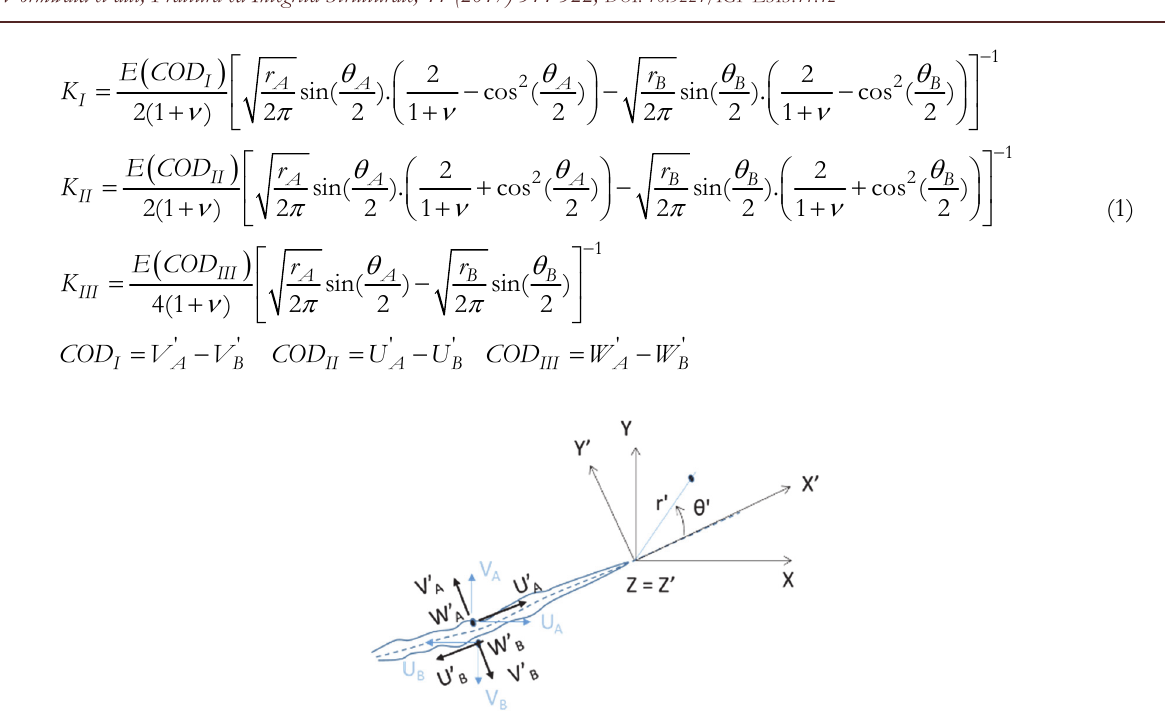
Figure 2: Displacements at points A, B located on the crack-flank and near to the crack